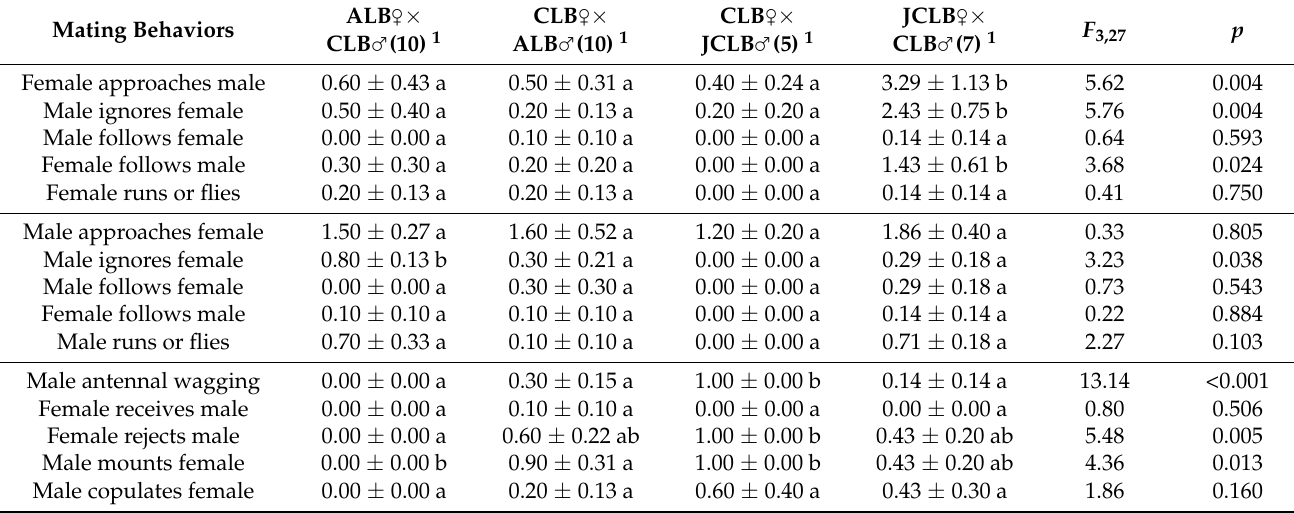
Table 1. Frequencies of reproductive behavioral events between Asian longhorned beetle (ALB), Anoplophora glabripennis and citrus longhorned beetle (CLB) A. chinensis or between CLB and A. malasiaca (JCLB) during a 30-minitue observations. Mating Behaviors